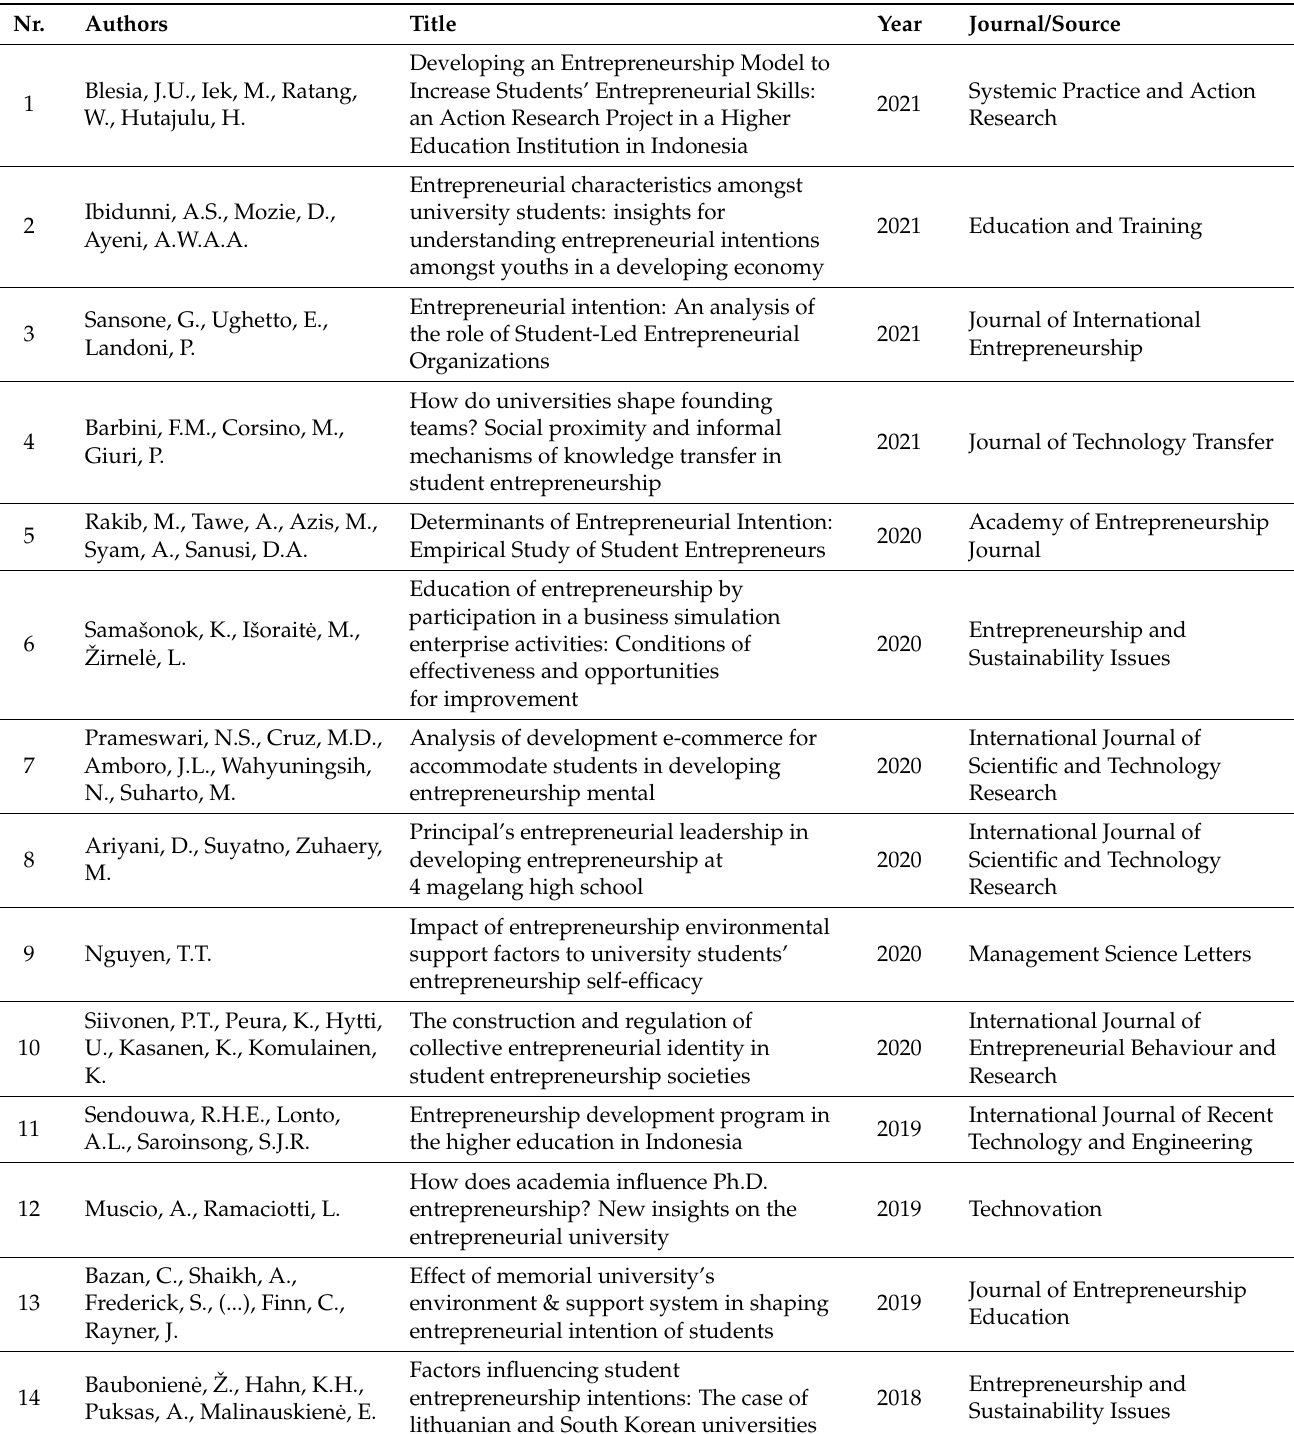
Table A1. Documents full list ordered by year of